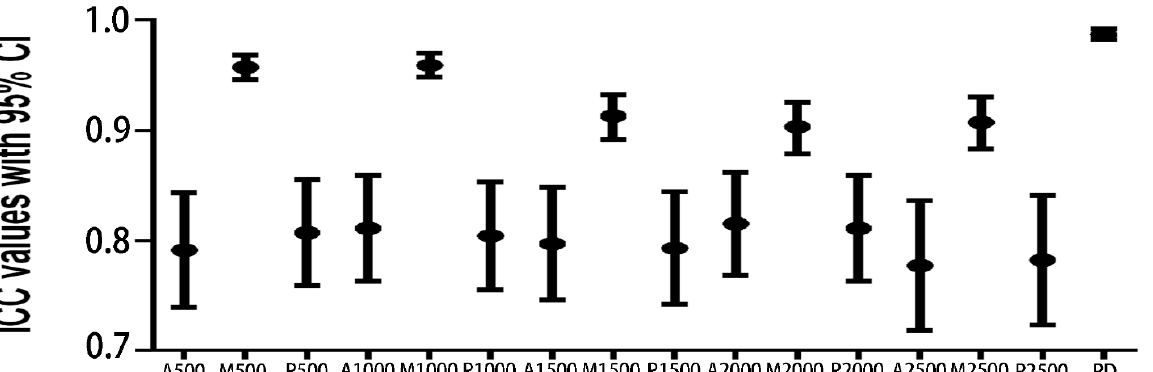
Figure 4. The intra-observer reproducibility of iris thickness and pupil diameter measurements. ICC: Intraclass correlation coefficient. CI: confidence interval. A: The anterior border layer, M: the middle stromal layer, P: the posterior pigmented epithelial layer. PD: Pupil diameter.